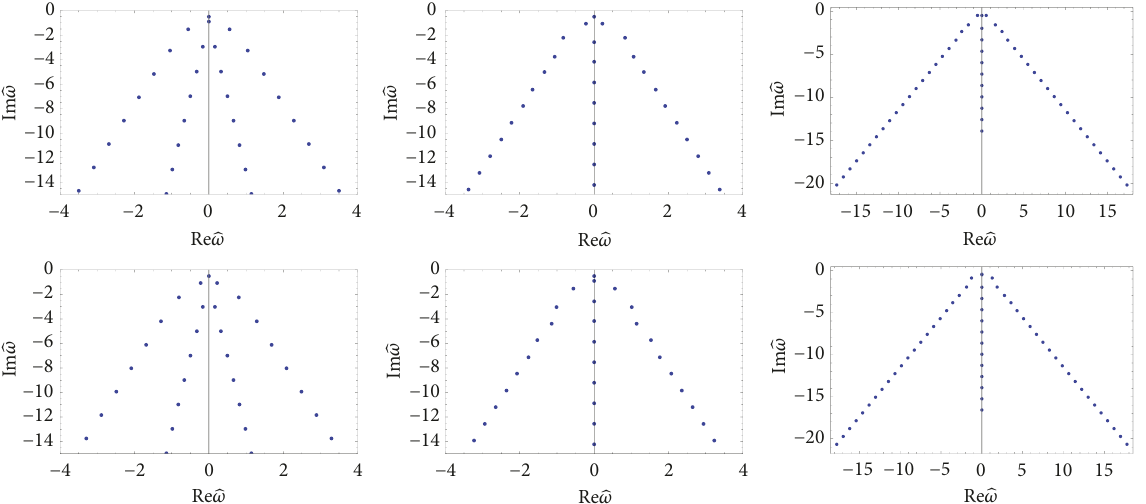
Figure 8: QNMs (blue spots) of the gauge mode for ̂𝛼 = 2/√3 . The first, second, and third columns are for 𝛾 1 = 0.02 , −0.02 , and −1 , respectively. The panels above are for the gauge mode, while the ones below are for the dual gauge